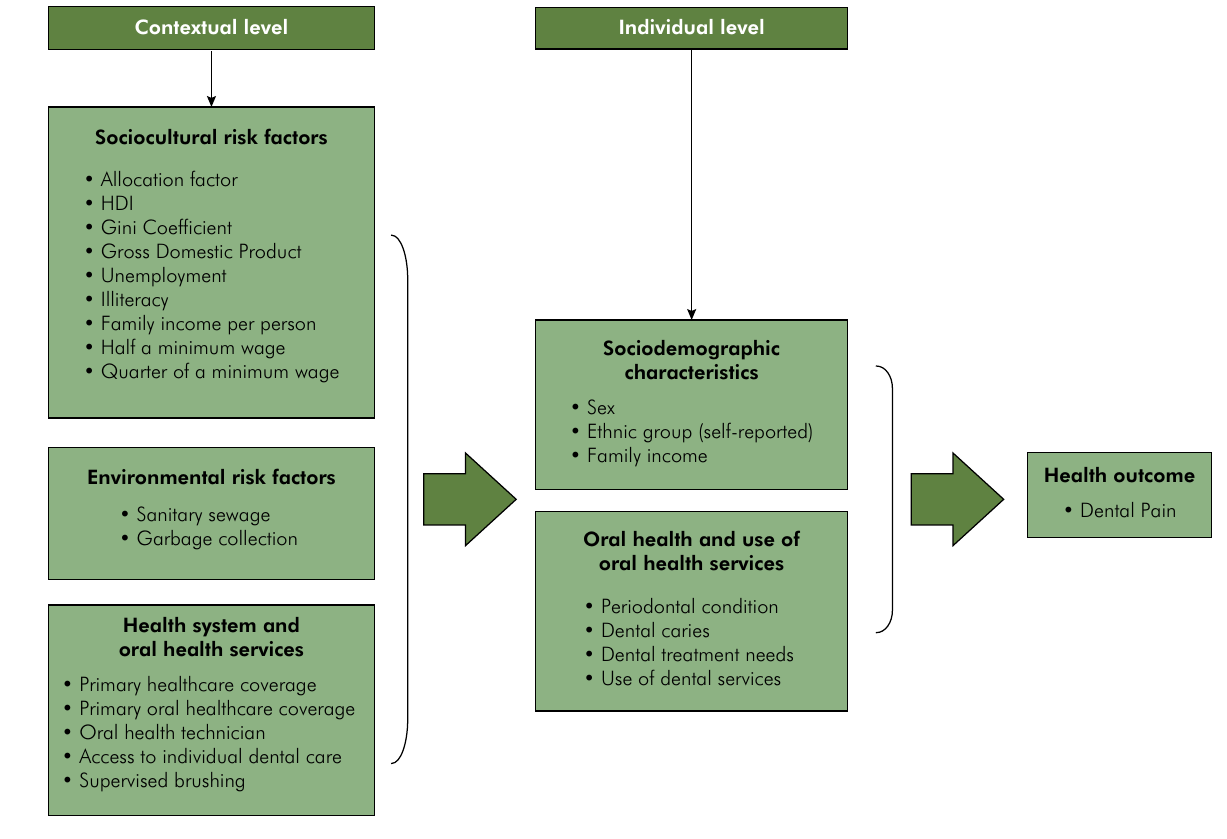
Figure. Conceptual model of risk factors for the toothache outcome. Adapted from Petersen’s framework.